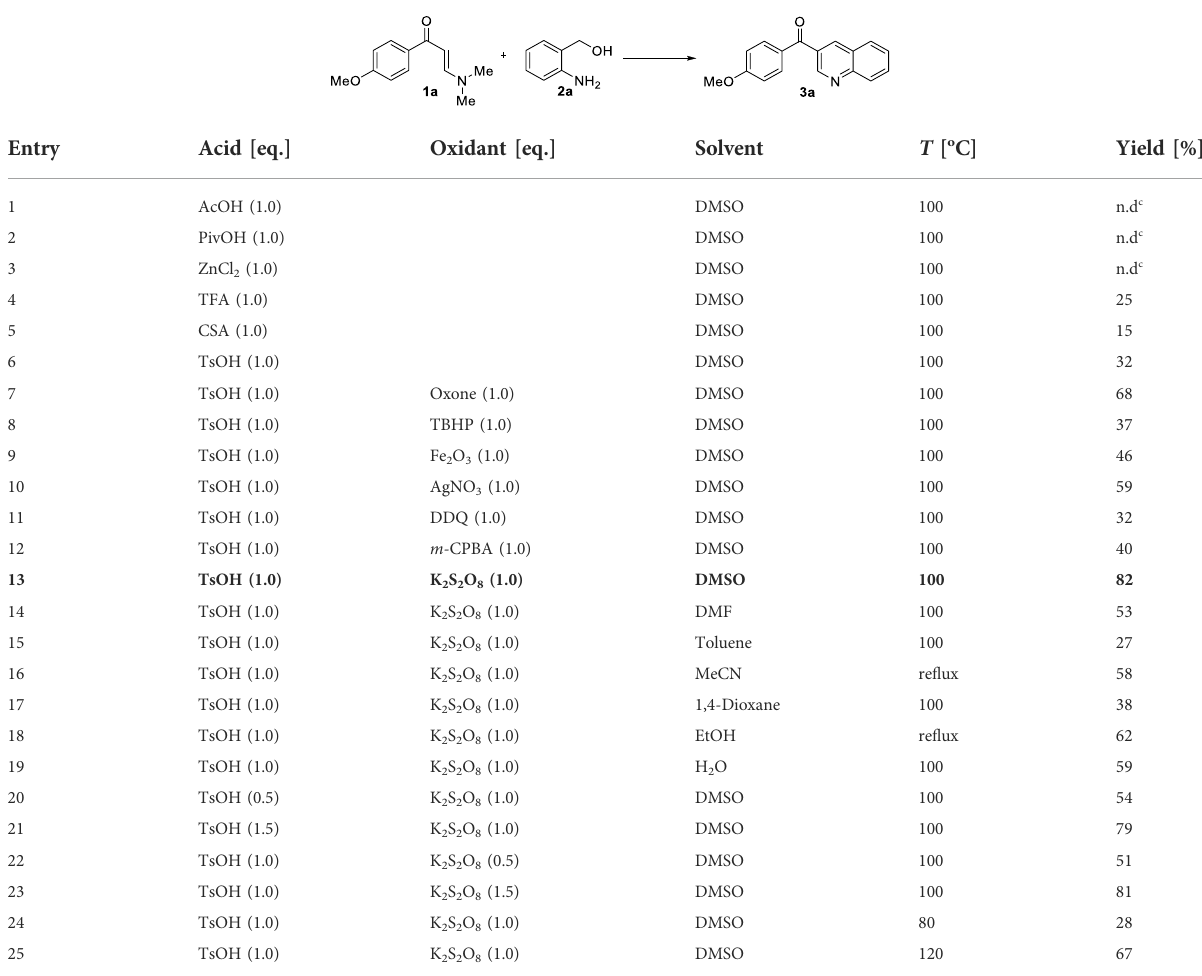
TABLE 1 Optimization of the reaction conditions.